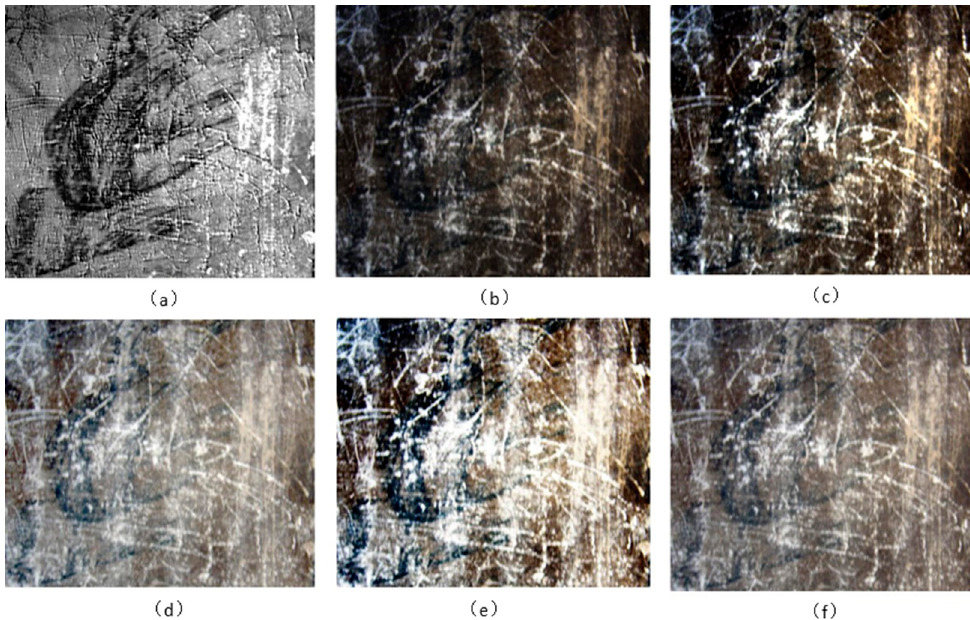
Figure 9. The enhancement results of area 1 with different methods. ( a ) Enhancement results of the method in this paper; ( b ) results using the linear method; ( c ) results using linear 2%; ( d ) results using the Gaussian method; ( e ) results using the equalization method; ( f ) results using the square root method.